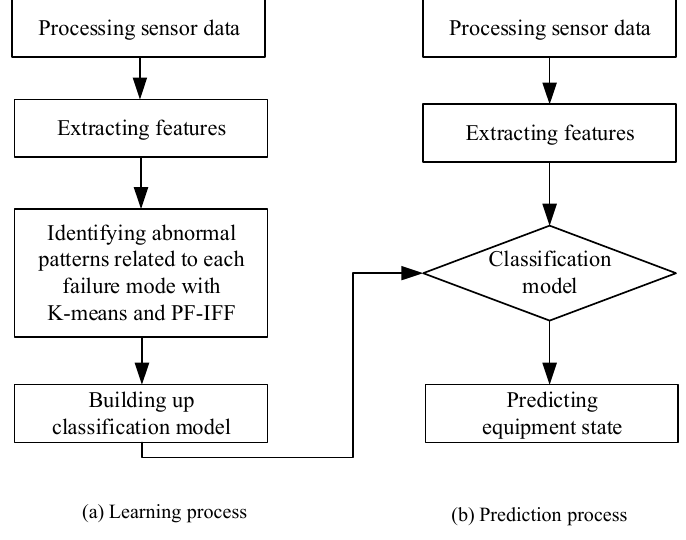
Figure 1. Proposed